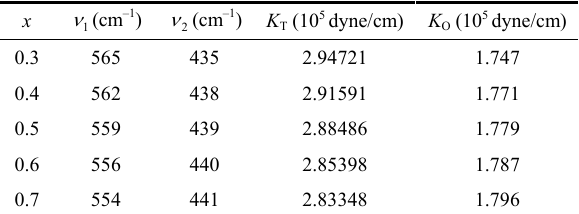
Table 6 Variations in ν 1 and ν 2 and K T and K O with